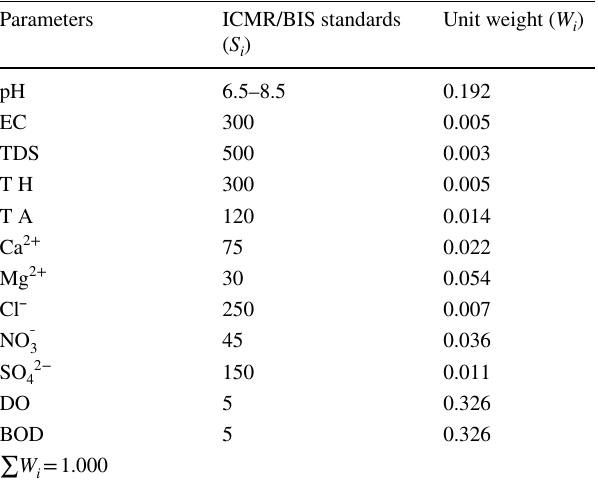
i ) of different parameters and their stand-